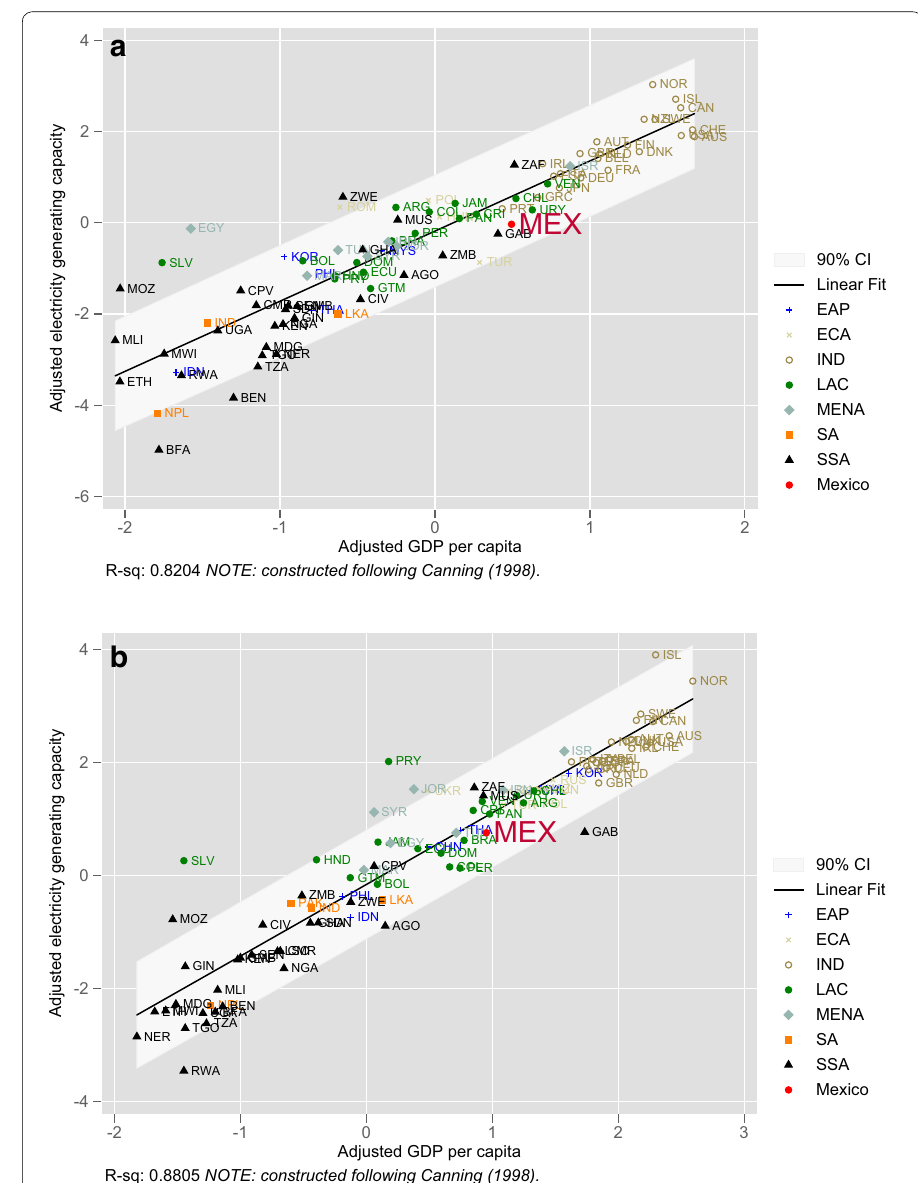
Fig. 5 Adjustments for Energy